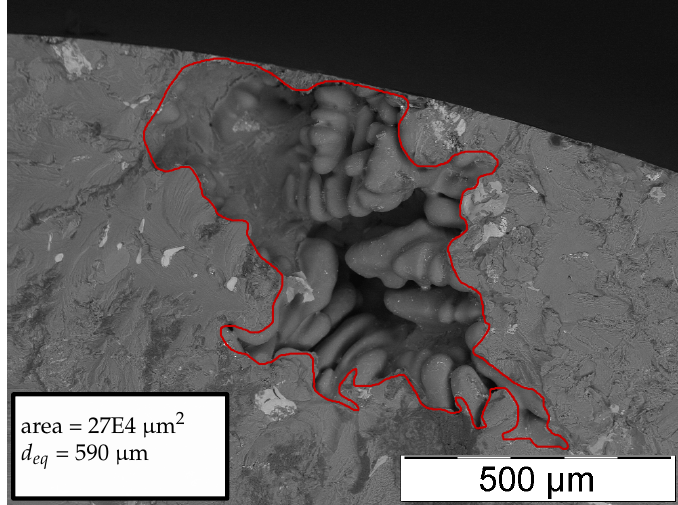
Figure 9. Representative fatigue fracture-initiating pore of position B.